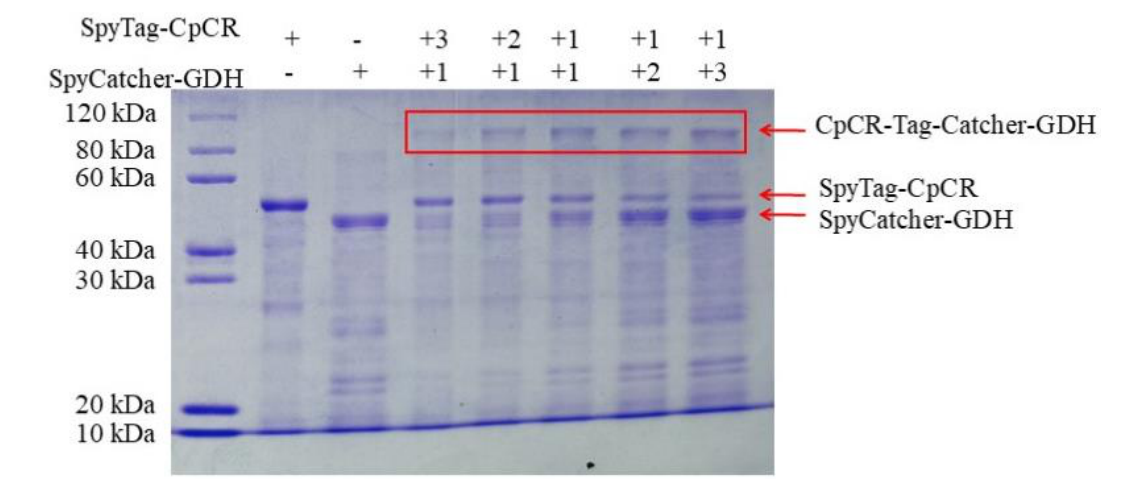
Figure 8. SDS-PAGE analysis of two groups of reactors assembled in different proportions. ( A ) Spy- Catcher-CpCR and SpyTag-GDH assembled. ( B ) SpyTag-CpCR and SpyCatcher-GDH assembled. Table 6. Assembly of BESCs with different molar ratios. Modular Protein Molar Ratio Assembly Efficiency